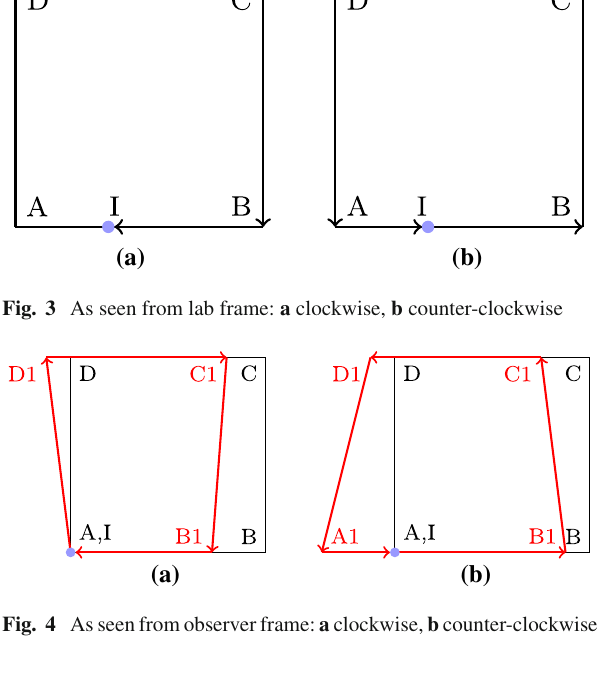
wise moving light beams